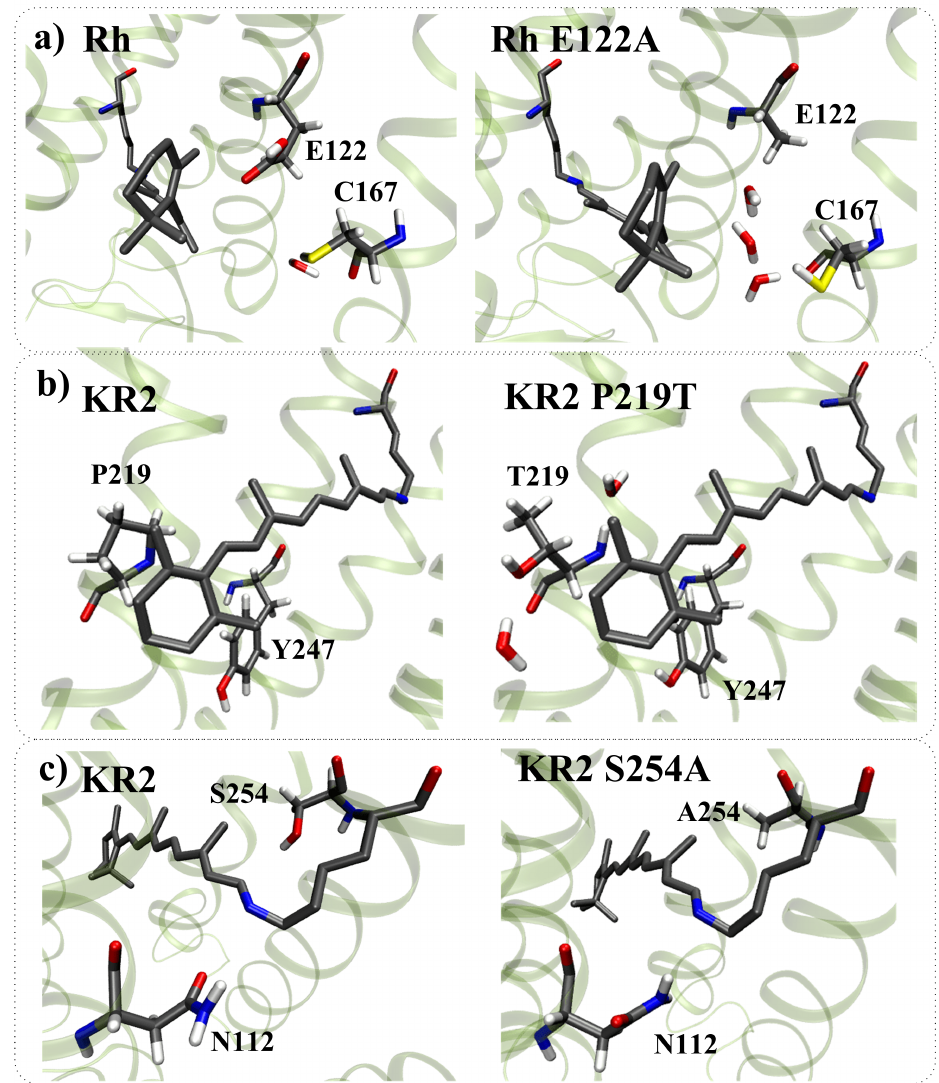
Figure 10. Structural reorganization caused by amino acid replacements. ( a ) E122A substitution in bovine rhodopsin (Rh); ( b ) P219T substitution in sodium pumping rhodopsin (KR2); ( c ) S254A substitution in sodium pumping rhodopsin